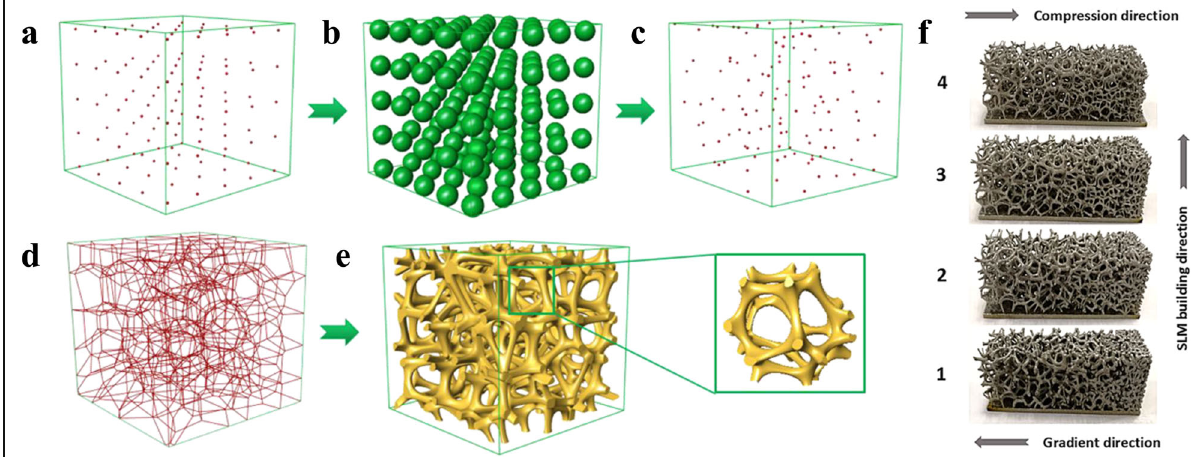
Fig. 17 Design process of porous scaffold based on Voronoi-Tessellation. a Lattice generation. b Sphere construction. c Irregular result. d Voronoi frame generation. e Resulting porous scaffold. f Addictive manufacturing